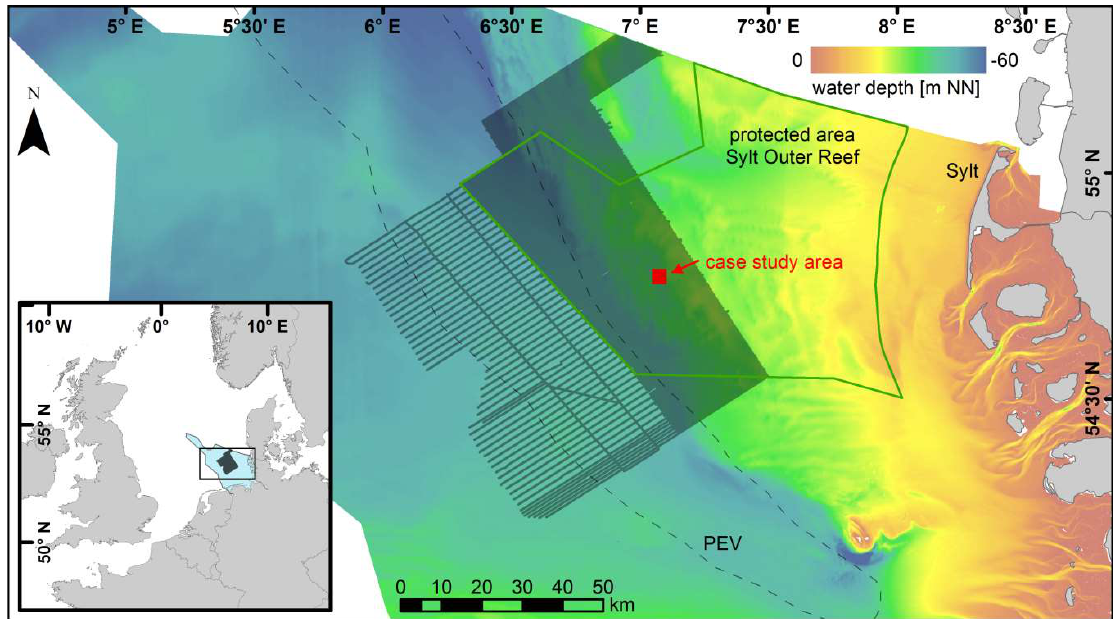
Figure 1. Map of the German Bight showing hydroacoustically covered area (black). The paleo Elbe valley (PEV) is crossing the study area (dashed line, modified after Behre [27]). The bathymetric data set is provided by the Federal Maritime and Hydrographic Agency of Germany.